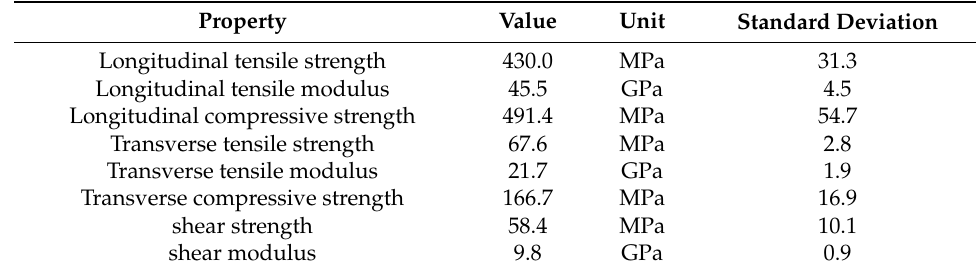
Figure 1. Sand-coated glass fiber-reinforced polymer (GFRP) plate. ( a ): Layers of pultruded GFRP plate; ( b ): Sand-coated treatment surface, (unit: cm). Table 1. Material property of pultruded GFRP.